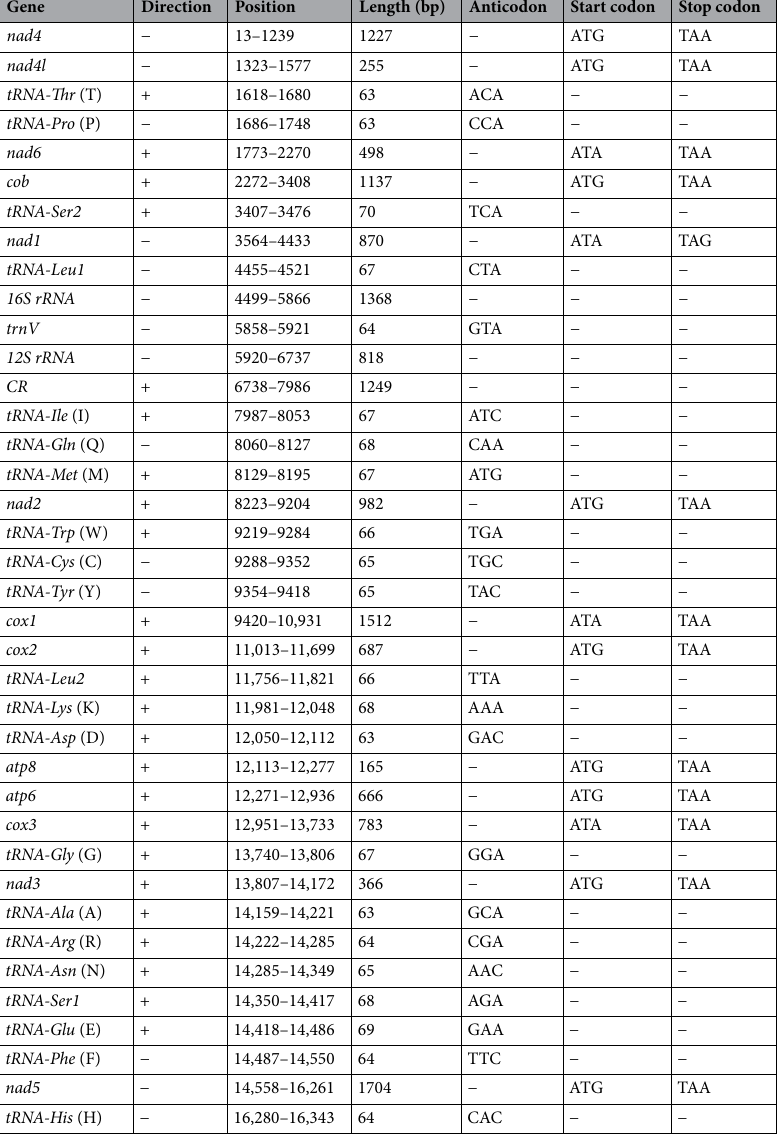
Table 1. Organization of the Exhippolysmata ensirostris mitochondrial